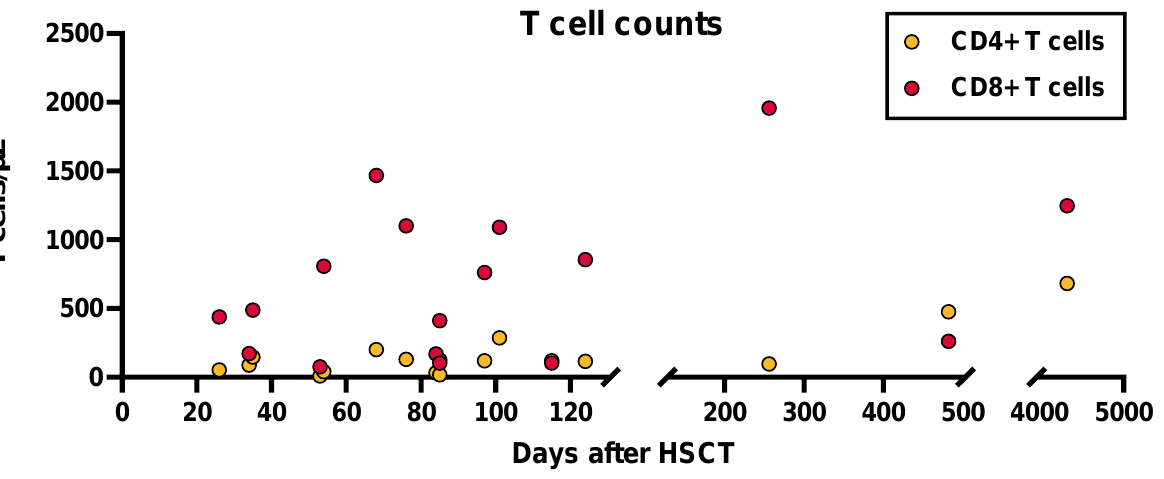
CD8+ T-cell counts ( r = 0.28, p = 0.3).